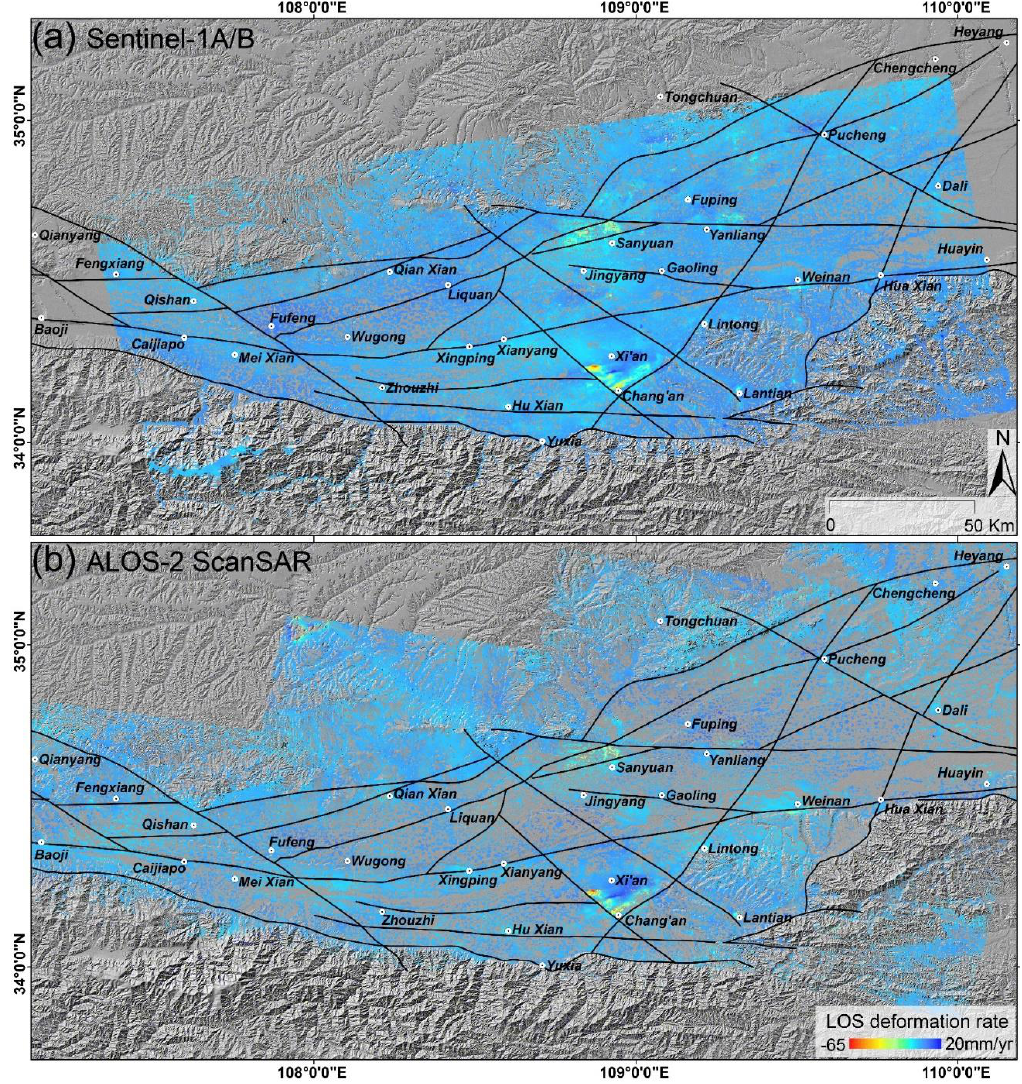
Figure 2. Mean LOS deformation rate during 2015 – 2019 generated by ( a ) Sentinel-1A/B and ( b ) ALOS-2 ScanSAR. Faults (black lines) and main cities are superimposed.